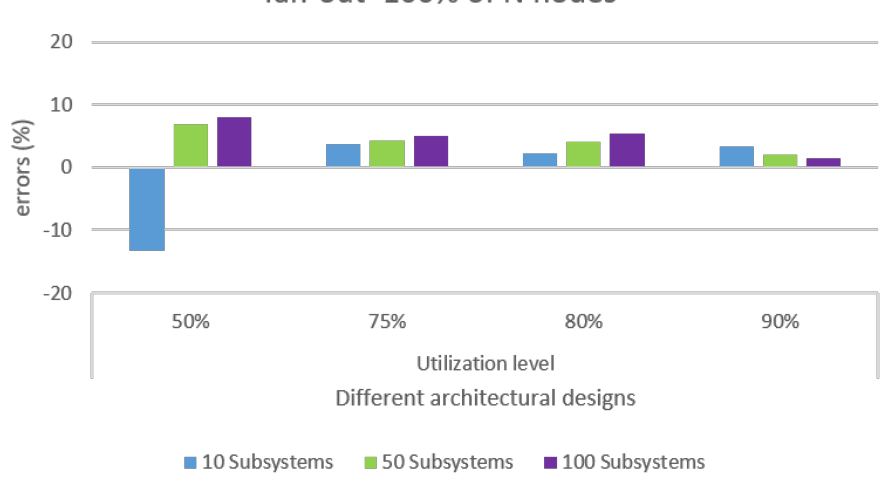
Figure 9. HFJQNs of applying different architectural designs at all fork nodes, where the black-box method is used in the